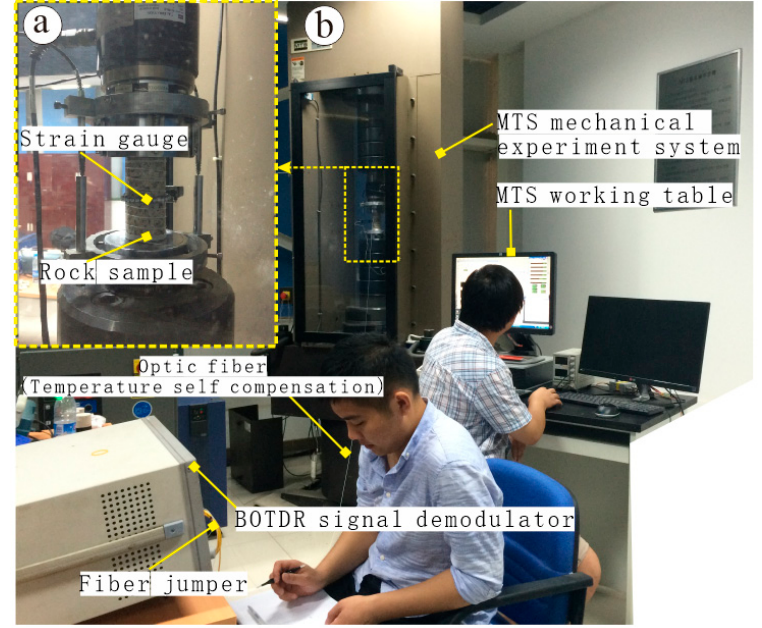
Figure 2. Test diagram of rock uniaxial fracturing system. ( a ) shows the strain gauge collection device; ( b )shows the test system global diagram ( b ) shows the test system global